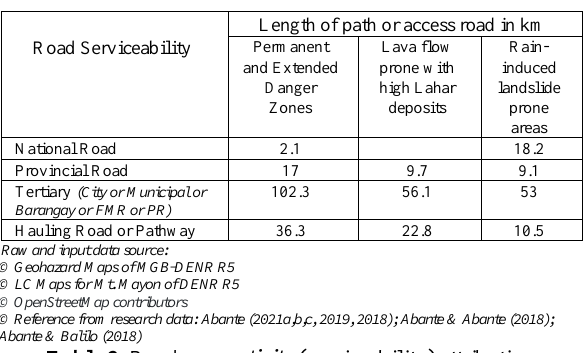
Table 2. Road connectivity (serviceability) attribution